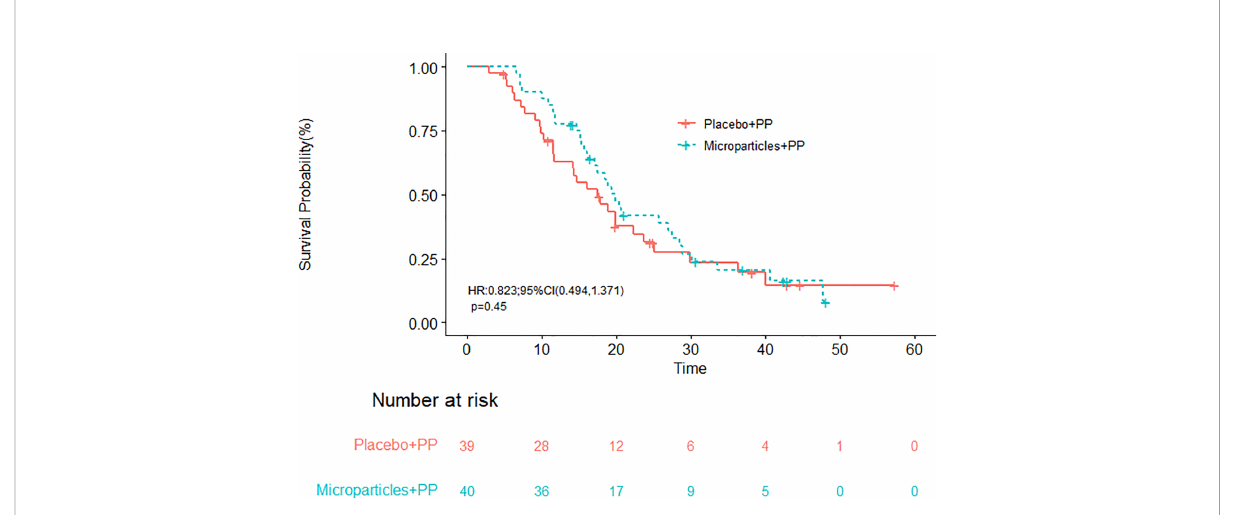
FIGURE 2 Overall survival of patients receiving the tumor cell-derived microparticles packaging methotrexate (TMPs-MTX) or saline combined with pemetrexed-cisplatin (PP)